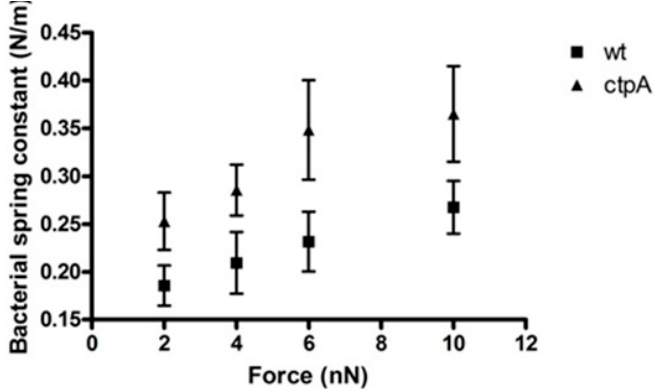
Figure 3. Bacterial spring constant of Rhizobium leguminsarum bv. viciae 3841 (wt) and 3845 (ctpA mutant) as a function of applied force. Spring constants were calculated from the ratio between the loading force and indentation depth during the linear response of a cell to the loading force. Values at 2 and 10 nN are statistically different ( p < 0.05).